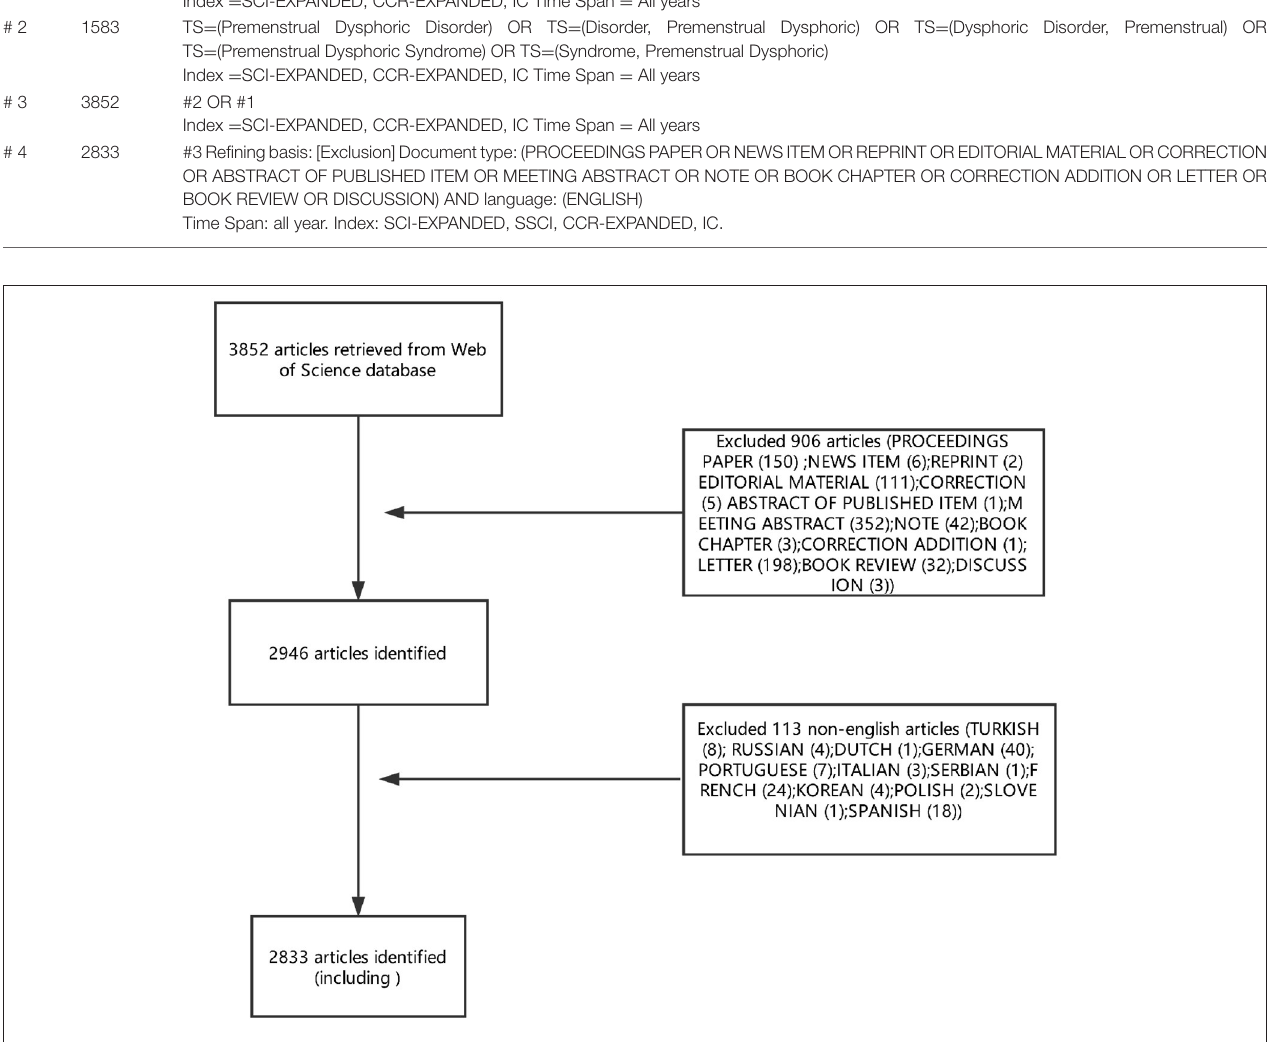
a hotspot, but a download trendency indicates that PMS/PMDD research attention tends to be